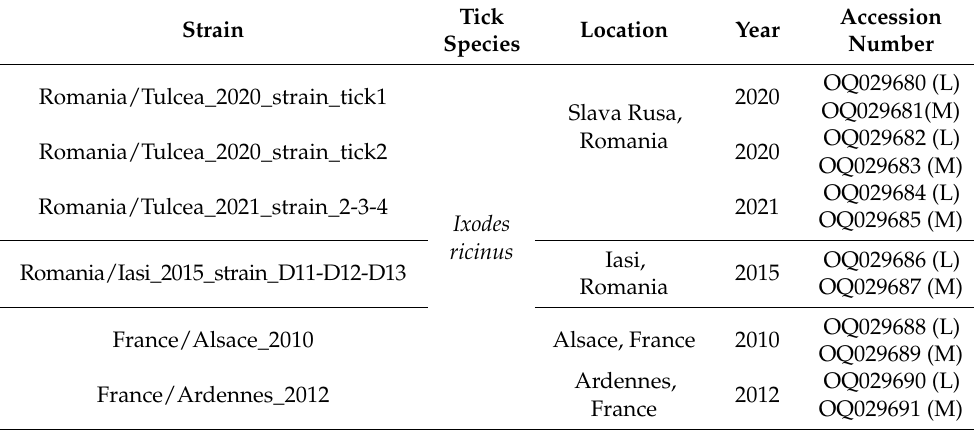
Table 2. BroBV strains identified in I. ricinus ticks from France and Romania. Tick Strain Species